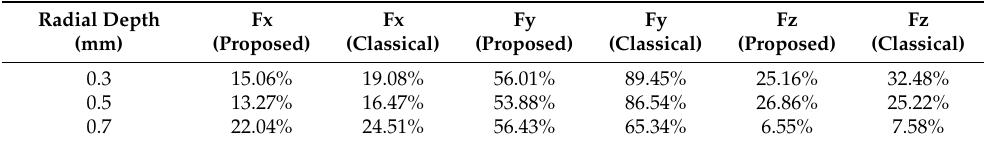
Table 7. Relative error of different feed